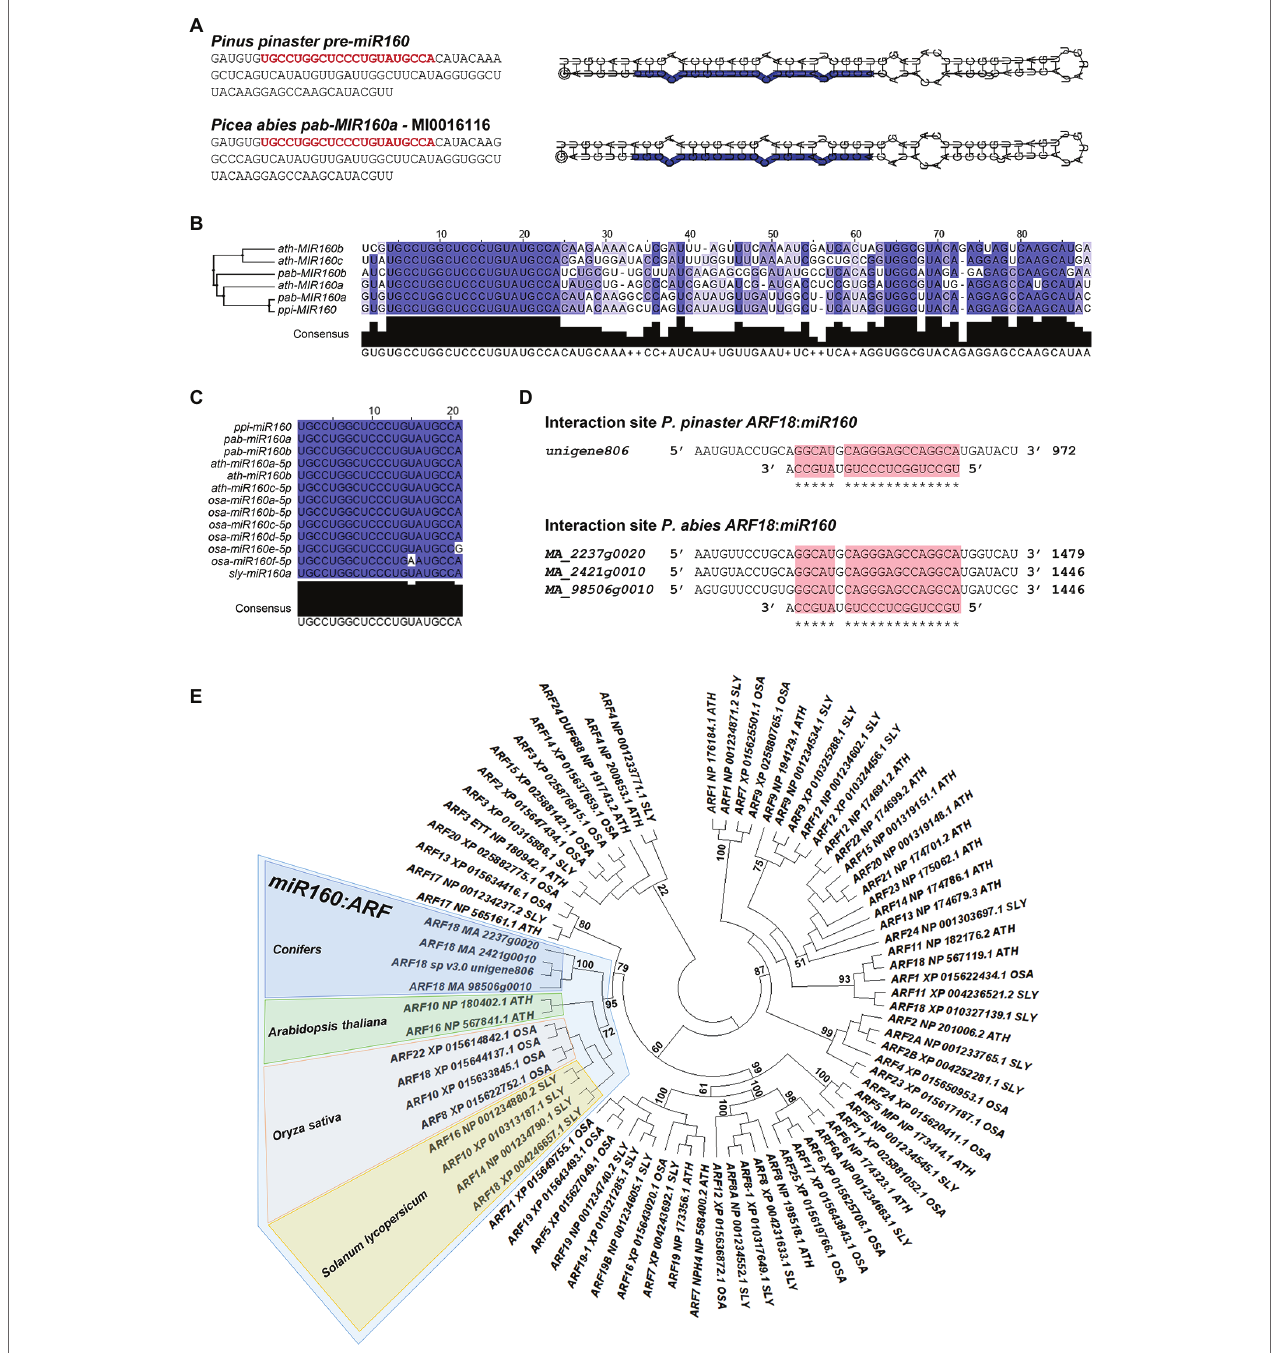
FIGURE 1 | In silico analysis of miR160: AUXIN RESPONSE FACTOR ( ARF ) interaction. (A) Pinus pinaster and Picea abies precursor-miR160 (pre-miR160) sequences. The sequence from P. pinaster was obtained in this work, whereas the P. abies sequence corresponds to MI0016116, annotated as pab-MIR160a in miRBase database. The miR160 mature sequence is highlighted in red. The shown secondary structures for both precursors were predicted and visualized using RNA Folding annotation tool implemented in the UEA sRNA workbench (Stocks et al., 2012). (B) Sequence alignment and phylogenetic tree constructed by the Maximum-Likelihood method of miR160 precursor sequences from Arabidopsis thaliana ( ath ), P. abies ( pab ) and P. pinaster ( ppi ). (C) Alignment of mature miR160 sequences from A. thaliana ( ath ), Oryza sativa ( osa ), Solanum lycopersicum ( sly ), P. abies ( pab ), and P. pinaster ( ppi ). High sequence conservation is represented in dark blue; white positions indicate no sequence conservation. (D) Target sites for miR160 in P. pinaster and P. abies transcripts annotated as AUXIN RESPONSE FACTOR 18 ( ARF18 ). The target site is indicated with a red box. (E) Phylogenetic tree of ARF protein sequences from A. thaliana , O. sativa , and S. lycopersicum and deduced amino acid sequences of ARF18 identified in conifers as potential target for miR160. The highlighted branch shows the more correlated proteins between the different species. The maximum-likelihood method was used with 1,000 bootstrap